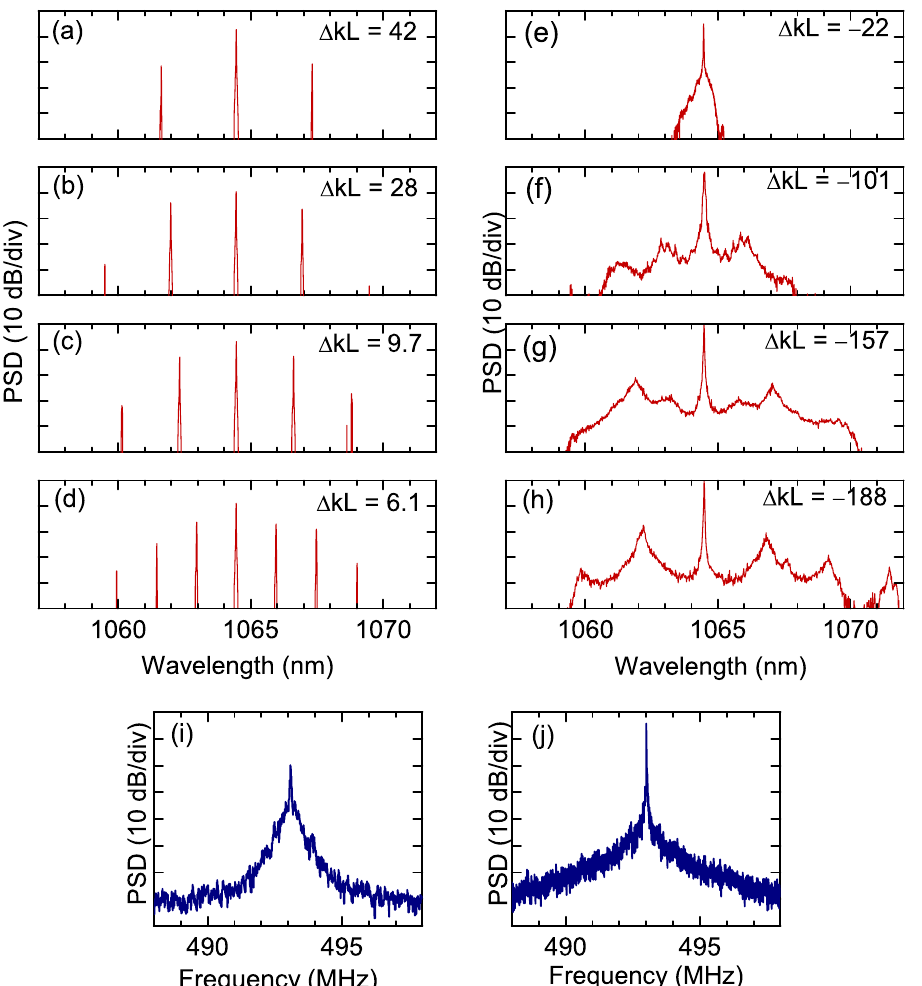
Figure 3. Optical spectra for phase-mismatched singly resonant cavity SHG. ( a – d ) Positive phase mismatch; ( e – h ) negative phase mismatch. Intermodal beat notes corresponding to ( i ) comb spectrum of Figure 2c, ( j ) comb spectrum in panel ( g